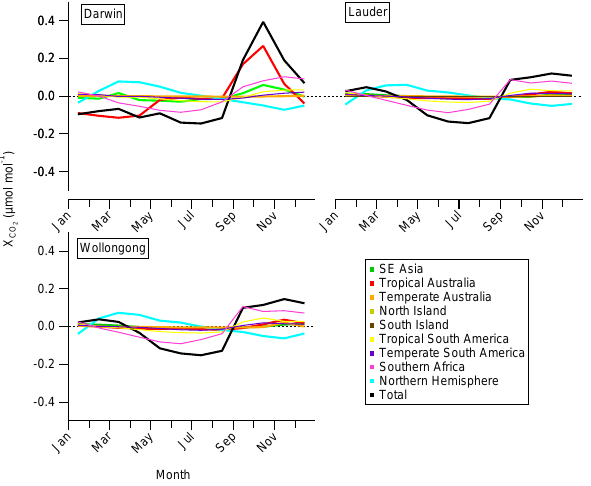
Figure 6. Regional decomposition of the mean seasonal cycles of the terrestrial biosphere in the TM3 simulation with SiB fluxes.